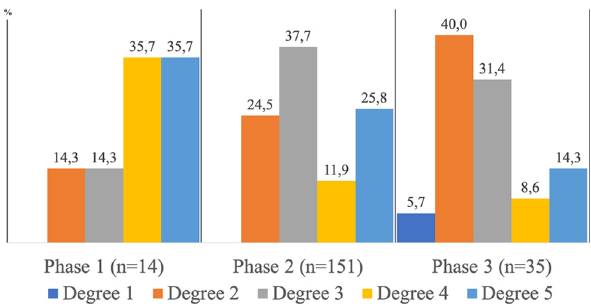
Figure 6: Histogram with the relative abundance ( % ) of burning damage degree according to the in fi lling phases of